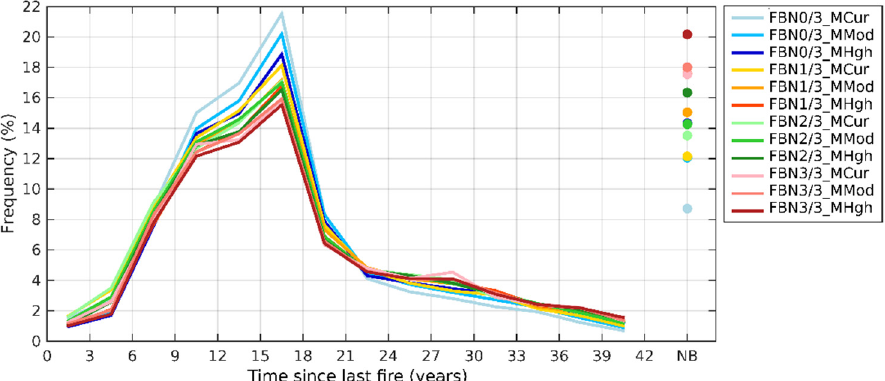
Figure 4. Simulated distribution of the number of years between wildfires, for the different fuel management scenarios; NB—the dots represent “not burned”.